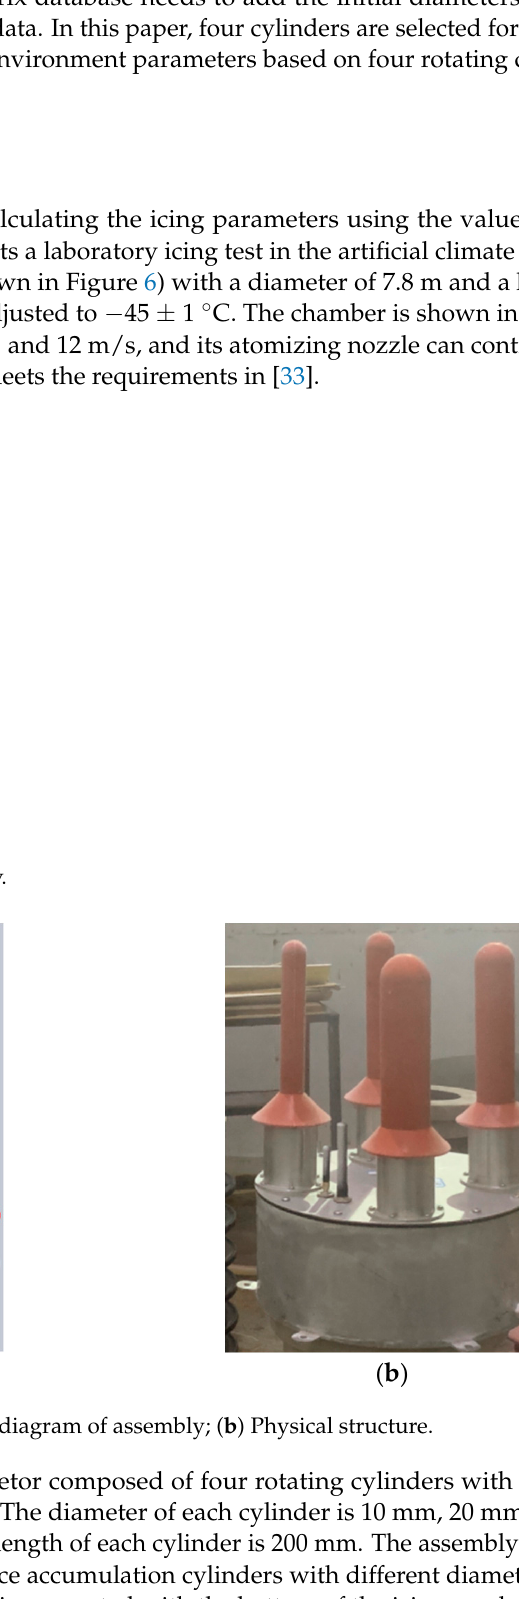
Figure 6. Artificial climate laboratory.